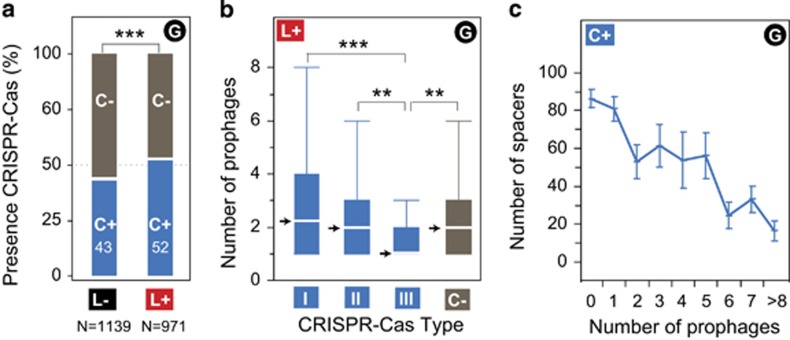
Analysis of the association between CRISPR-Cas systems and lysogeny among all the bacterial genomes (G). (a) Presence of CRISPR-Cas systems among lysogens (52%, L+) and non-lysogens (43%, L−) (***significant difference: P<10−4, χ2 test). (b) Distribution of the number of prophages per bacterial genome in lysogens (L+) in function of the presence of the different CRISPR-Cas systems (I, II, III) or when they are all absent (C−). Bacterial genomes encoding type III systems have fewer prophages than the others (***P<10−4 and **P<10−3, Wilcoxon test). Arrows indicate medians. (c) Distribution of the number of spacers in CRISPR arrays of bacterial genomes encoding CRISPR-Cas systems (C+) in function of the number of prophages per bacterial genome (Spearman's ρ=−0.21, P<10−4).